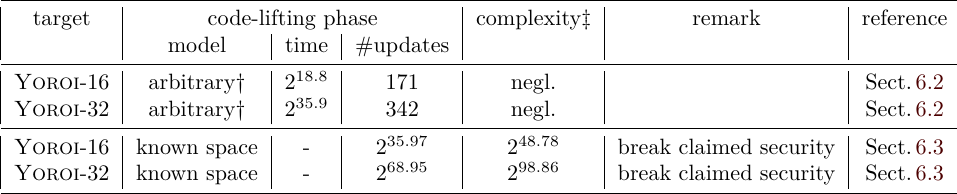
Table 2: Summary of attacks on the longevity of Yoroi